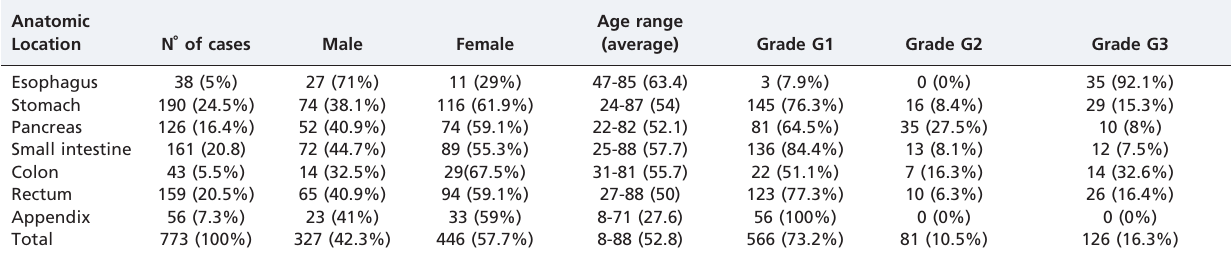
Table 1 - The distribution of the 773 GEP-NETcases by anatomical location, gender, age, and grading. Anatomic Location